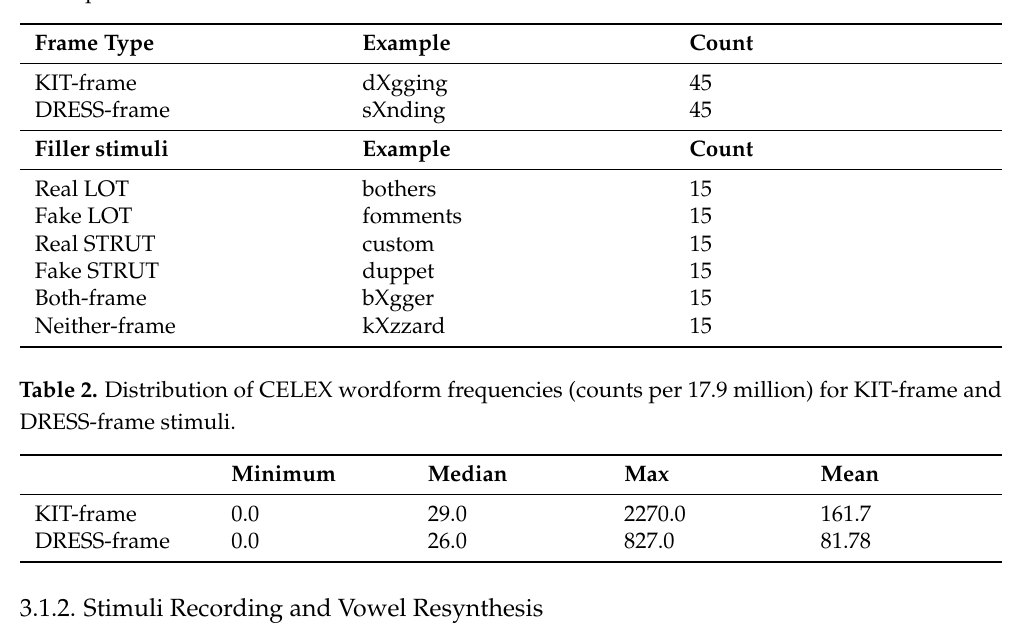
Table 1. Distribution of stimuli for experiment one across word-type for target items and fillers over three speakers.